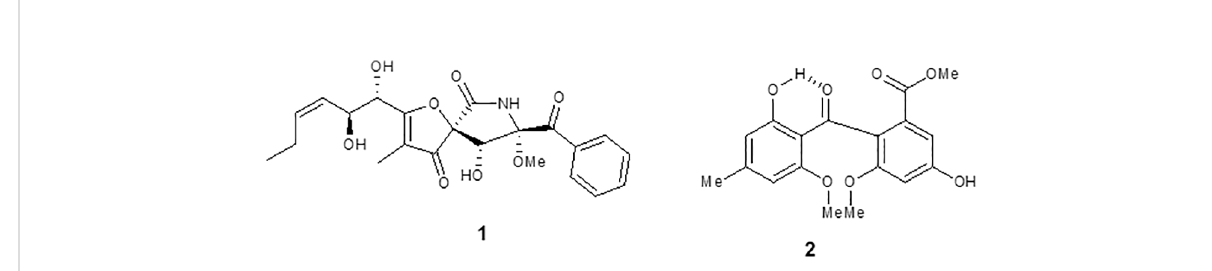
FIGURE 2 Chemical structure of compounds isolated from Aspergillus sp. (1) pseurotin A and (2) monomethylsulochrin.